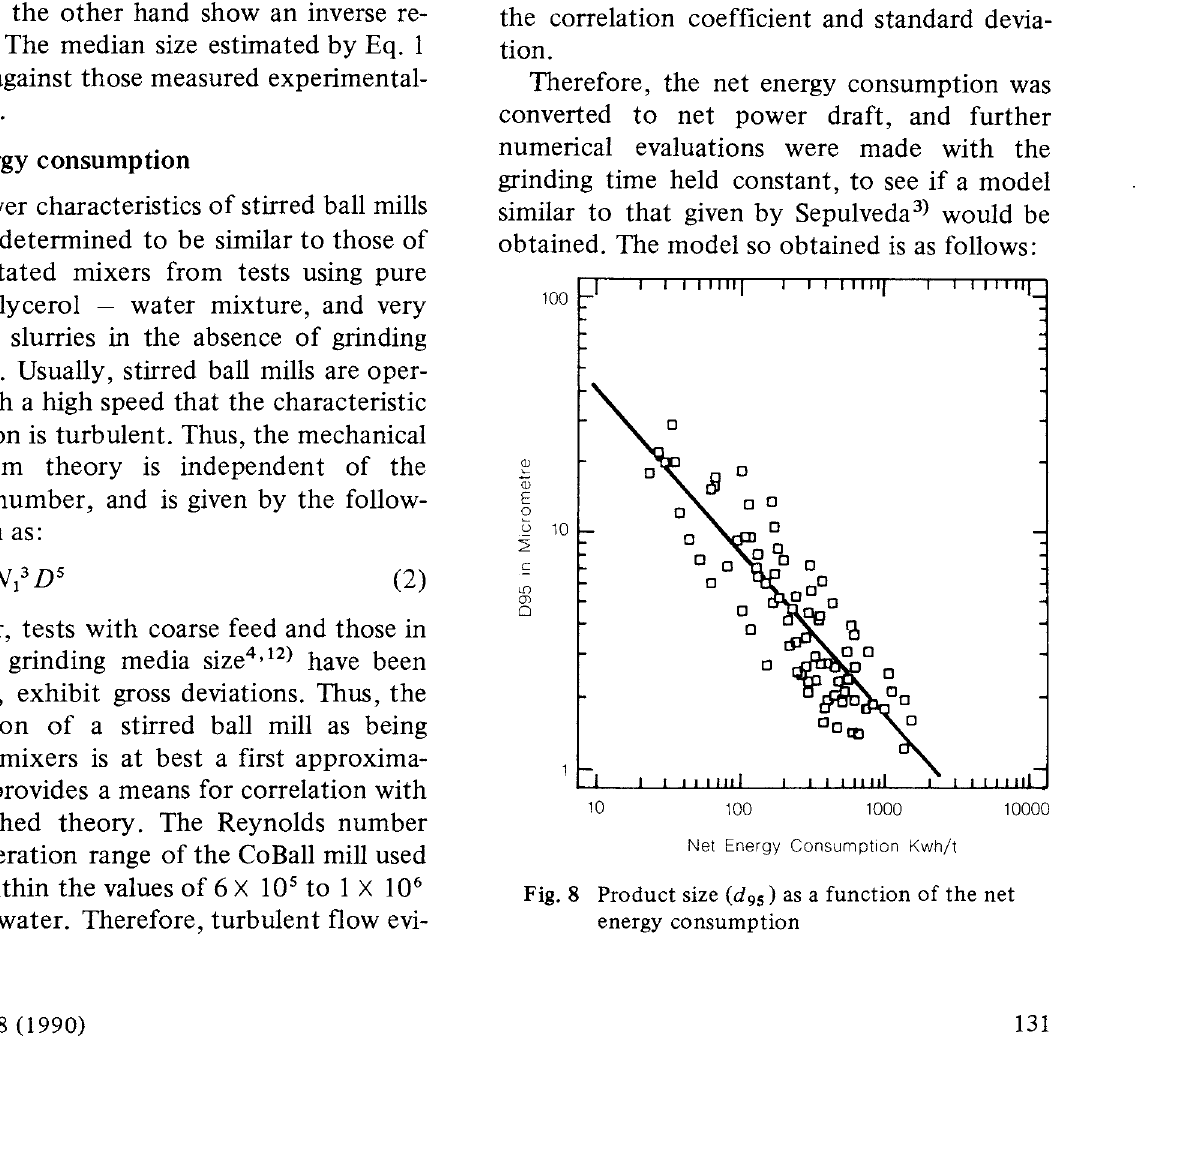
Fig. 7 The relationship between estimated and measured product median size